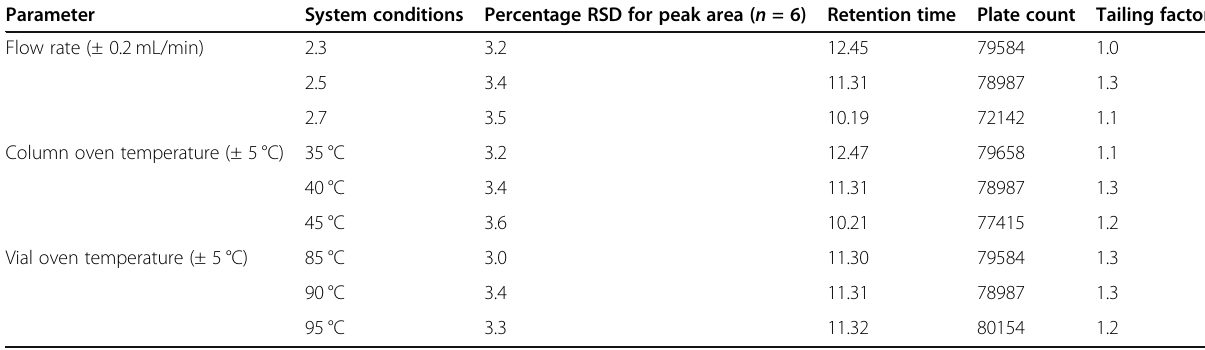
Table 24 Robustness study results of N- hexane